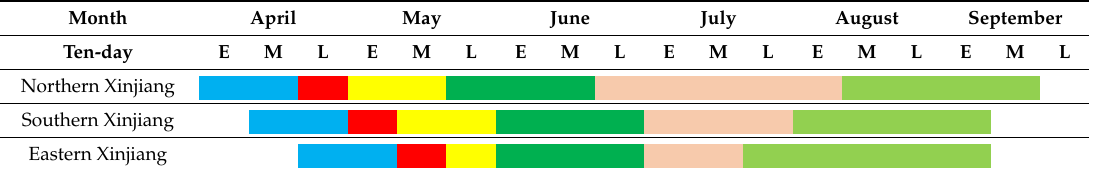
Table 1. Phenological calendar of cotton in Xinjiang.